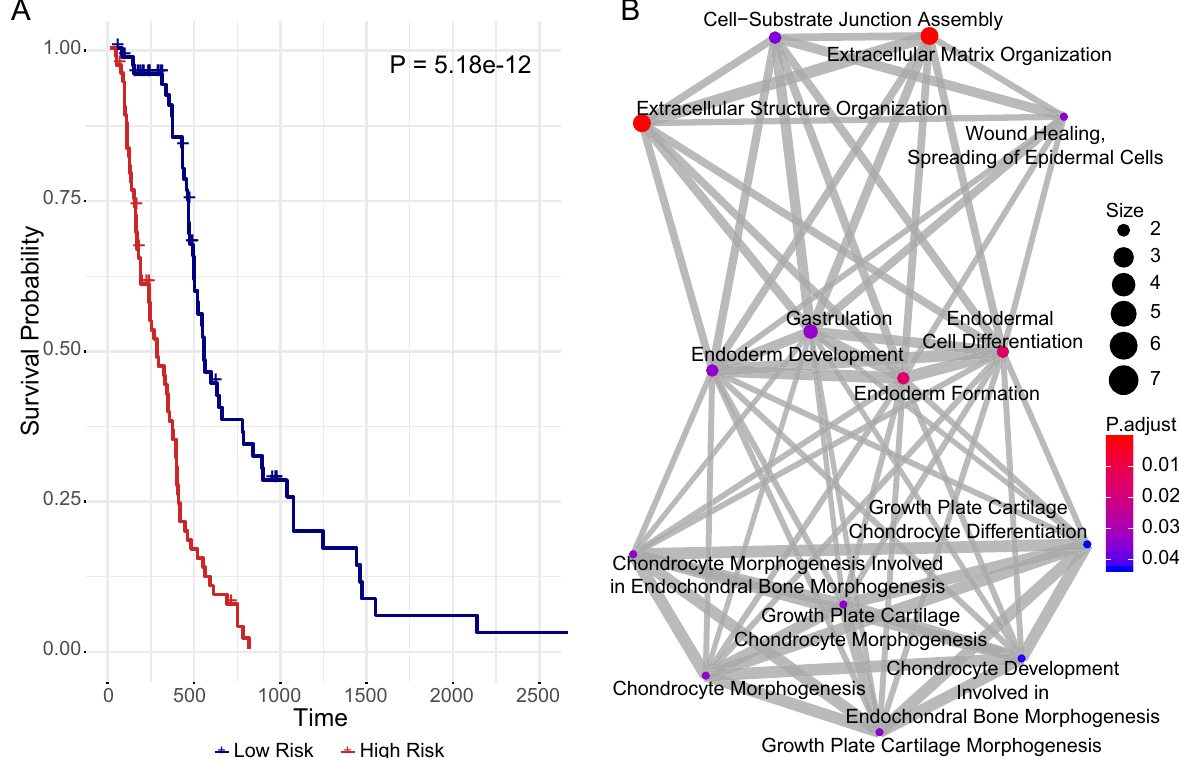
Figure 2. The up-regulated potential prognostic genes are correlated with prognosis and the processes of cell biology. ( A ) Survival curves of patients with Glioblastoma. The high-risk group indicates the high-risk score and the low-risk group indicates the low-risk score. The groups between low and high-risk scores were stratified according to the median expression level of the risk score. Data were analyzed by log-rank test.The X-axis indicates time in days. ( B ) the results of Go analysis about these 33